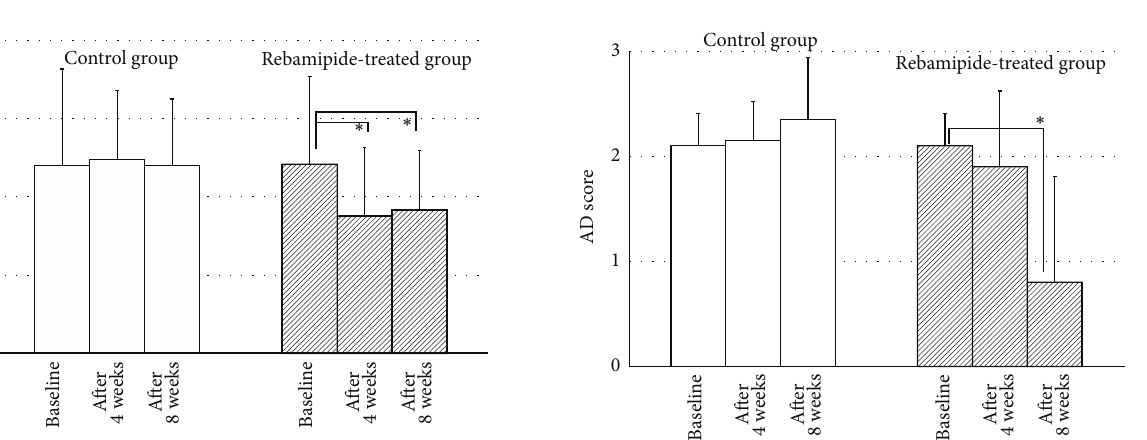
Figure 4: Changes in AD score in the rebamipide-treated group andcontrolgroup.Treatmentwithrebamipideresultedinsignificant improvements in keratopathy at 8 weeks, but there were no changes at 4 weeks. However, no significant difference was observed in the control group. ∗ 𝑃 < 0.001